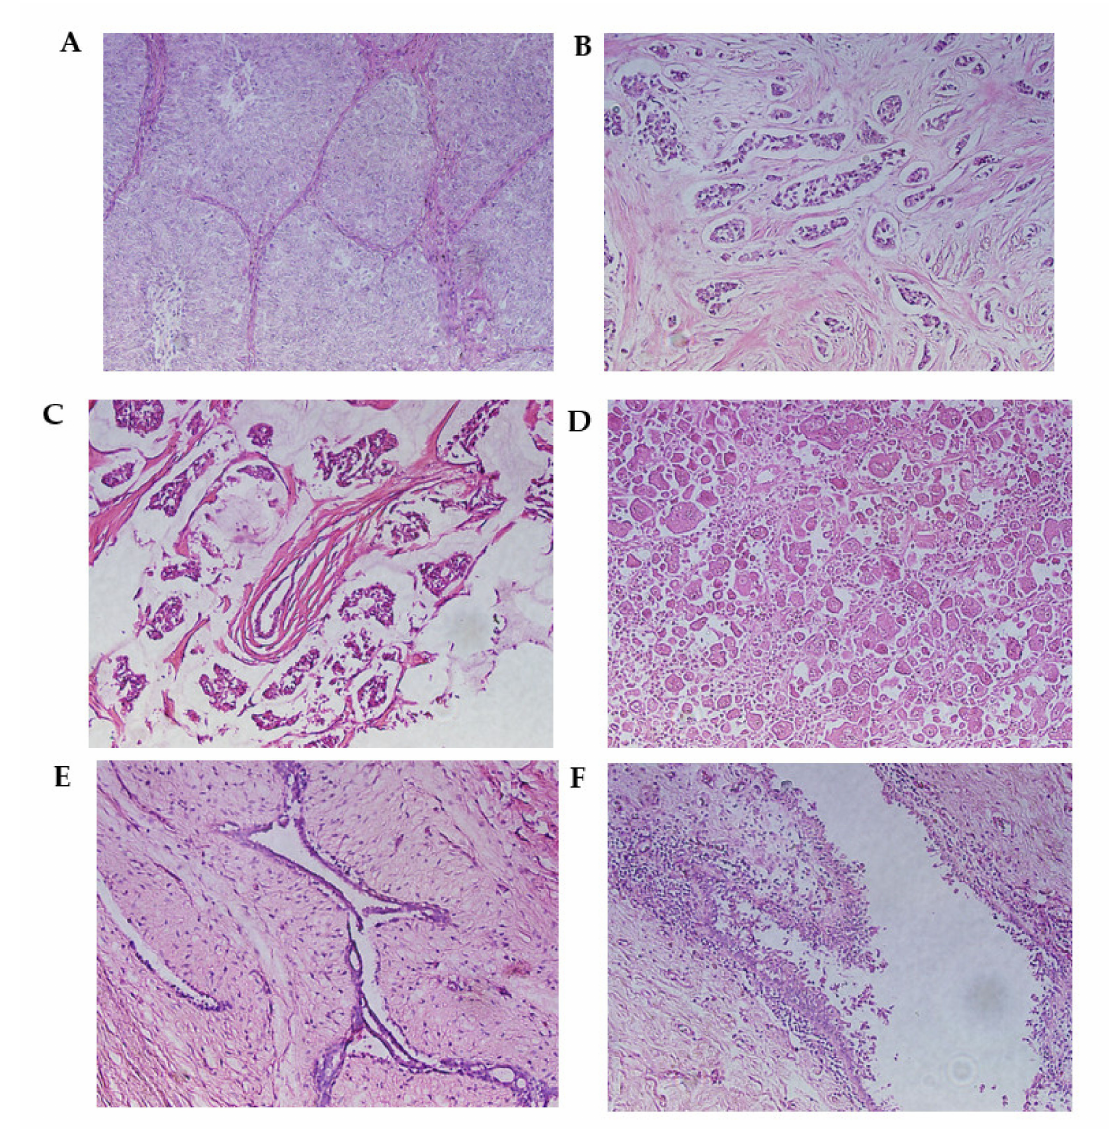
Figure 1. Malignant breast neoplasms. ( A ) Infiltrating ductal carcinoma (solid pattern) separated by connective tissue septa. ( B ) Infiltrating lobular carcinoma. This is characterized by the invasion of the stroma in the form of fine cell cords, called Indian row cords. ( C ) Mucinous carcinoma. Tumor cells are seen within lakes of mucin. ( D ) Metaplastic carcinoma. ( E ) Fibroadenoma. The proliferation of cells can be observed, creating well-defined borders concerning the surrounding normal tissue. ( F ) Mastopathy with hyperplasia. A duct with apocrine metaplasia and foci of hyperplasia can be observed. Hematoxylin and eosin staining. Optical microscopy magnification 20 ×